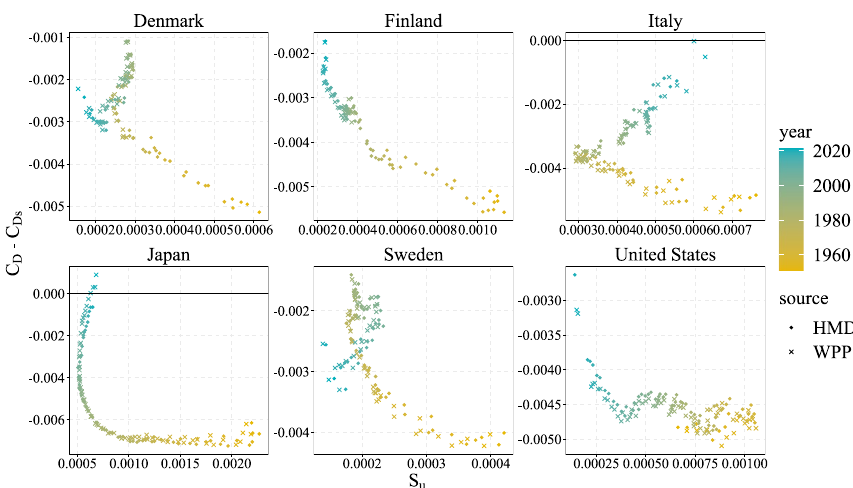
Fig. 13 The deviation ( S u ) and the sensitivity ( C D — C Ds ) in 6 countries from HMD and WPP,